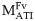
Active stretch experiments.Initial half-sarcomere length inhomogeneity is introduced via variation of passive (left column) and active (right column) material properties (see text). Top: Total stress evolution in models MATIFv (black dashed line) and MATI (red line) following a protocol of passive stretch from L/L0 = 1.0 to 1.05 (phase I, i.e., computing the passive stretch as shown in Fig 6), full activation at fixed length (phase II), active stretch at a velocity of v/vmax = 13.3% from L/L0 = 1.05 to 1.25 (phase III), and subsequent fixed-length contraction (phase IV). Additionally, the stress resulting from a fixed-length contraction (model MATIFv) at the same final length L/L0 = 1.25 is shown (blue dotted line). The kink in the red line during the active stretch marks the transition from the plateau to the descending limb of the force—length relation. Note that we excluded stresses from models MFv and Mxx from these figures, since these models cannot reproduce the expected forces on the descending limb (previously shown, see e. g. Fig 6). Bottom: Coefficient of variation (CoV, standard deviation/mean*100%) of the half-sarcomere lengths corresponding to the above stretch experiments.